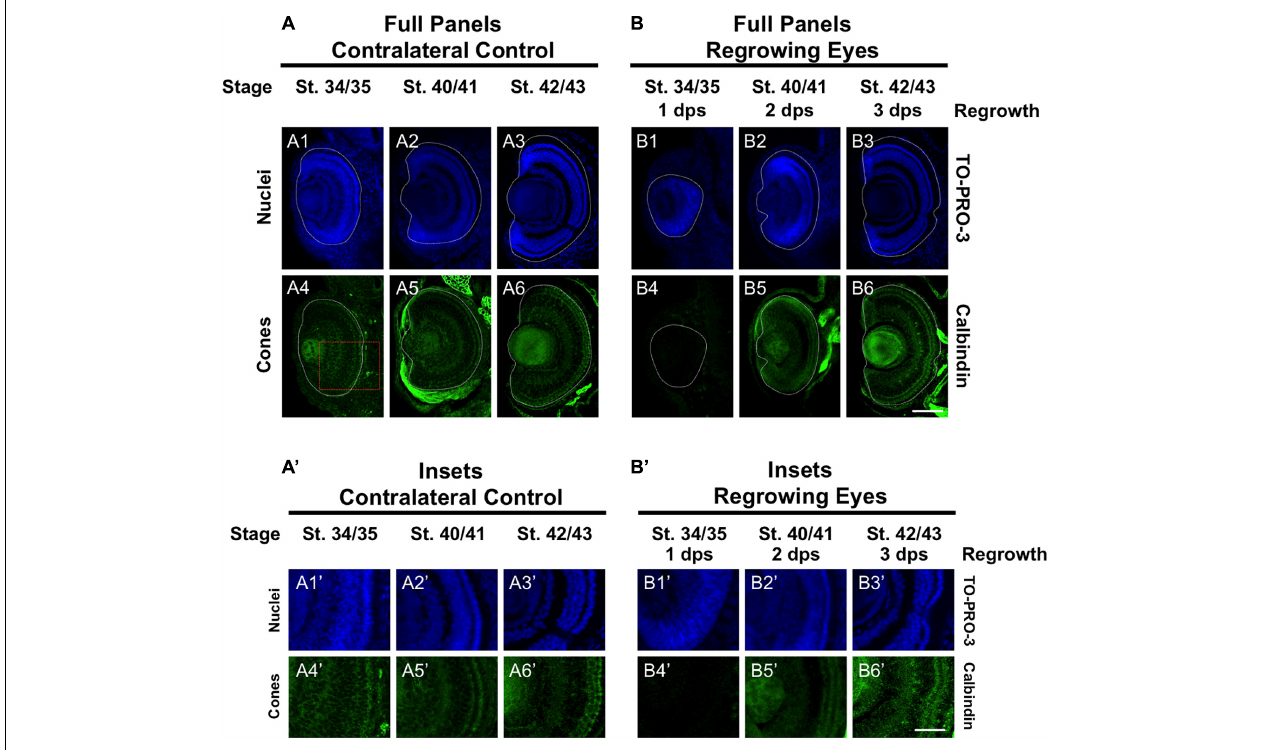
FIGURE 3 | Regrown eyes regain cone differentiation by 3 dps. Images shown are immunostained, transverse sections at three developmental timepoints corresponding to 1, 2, and 3 days post surgery (dps). (A,B) Differentiation of cone photoreceptor cells is delayed during 1, 2 dps but regains patterning that is comparable to contralateral control eyes (unoperated) by 3 days. White dashed lines delineate each eye. (A’,B’) Images shown in panels A’ and B’ correspond to the region shown in the inset box in panel A4 for the corresponding A or B panel at high magnification. Blue color indicates nuclear staining (TO-PRO-3). Green color indicates anti-Calbindin signal (cone photoreceptors). Sample sizes: 1 day, n = 6; 2 days, n = 5; and 3 days, n = 6. (A,B, A’,B’) Up = dorsal, down = ventral, lens is on the left. Scale bar: A,B = 100 µ m and A’,B’ = 50 µ